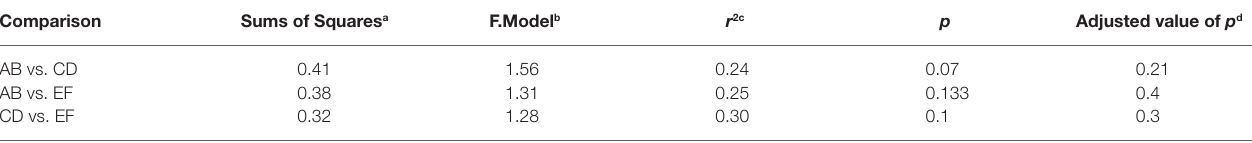
TABLE 2 | Pairwise Adonis of the three batches of unpasteurized milk used for Gouda cheese manufacture. Comparison